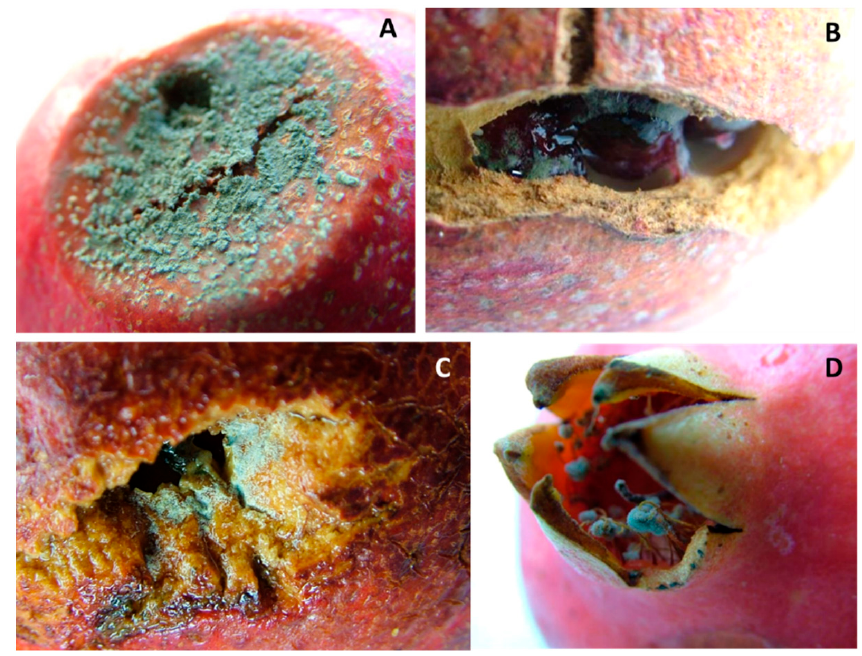
Figure 2. Penicillium s.l. decay. ( A ) Necrotic lesion covered with blue-greenish sporification. ( B ) Cracking ( C ) wound and ( D ) infected stamens.